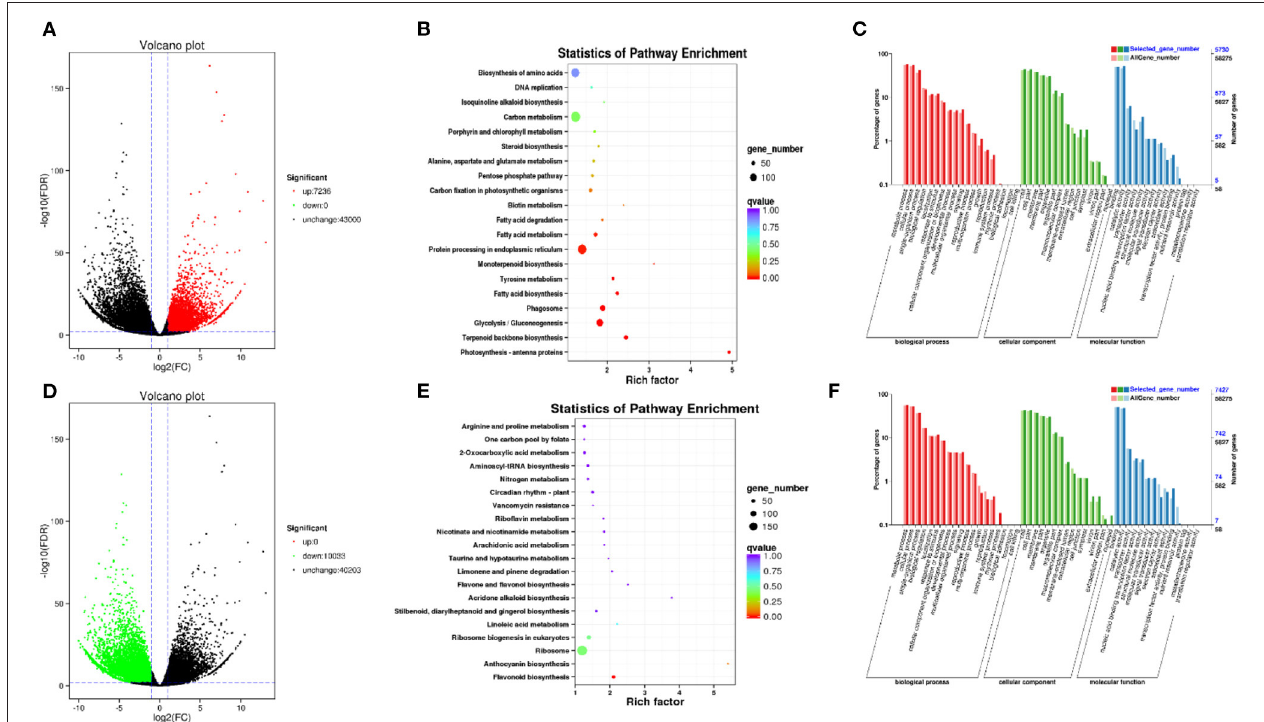
FIGURE 2 | Analysis of differentially expressed genes in red and green prickly ash fruit across all growth periods. (A) Volcano plot of genes upregulated in green prickly ash. (B) KEGG enrichment analysis of the genes in (A) . (C) GO enrichment analysis of the genes in (A) . (D) Volcano plot of genes downregulated in green prickly ash (upregulated in red prickly ash). (E) KEGG enrichment analysis of the genes in (D) . (F) GO enrichment analysis of the genes in (D)